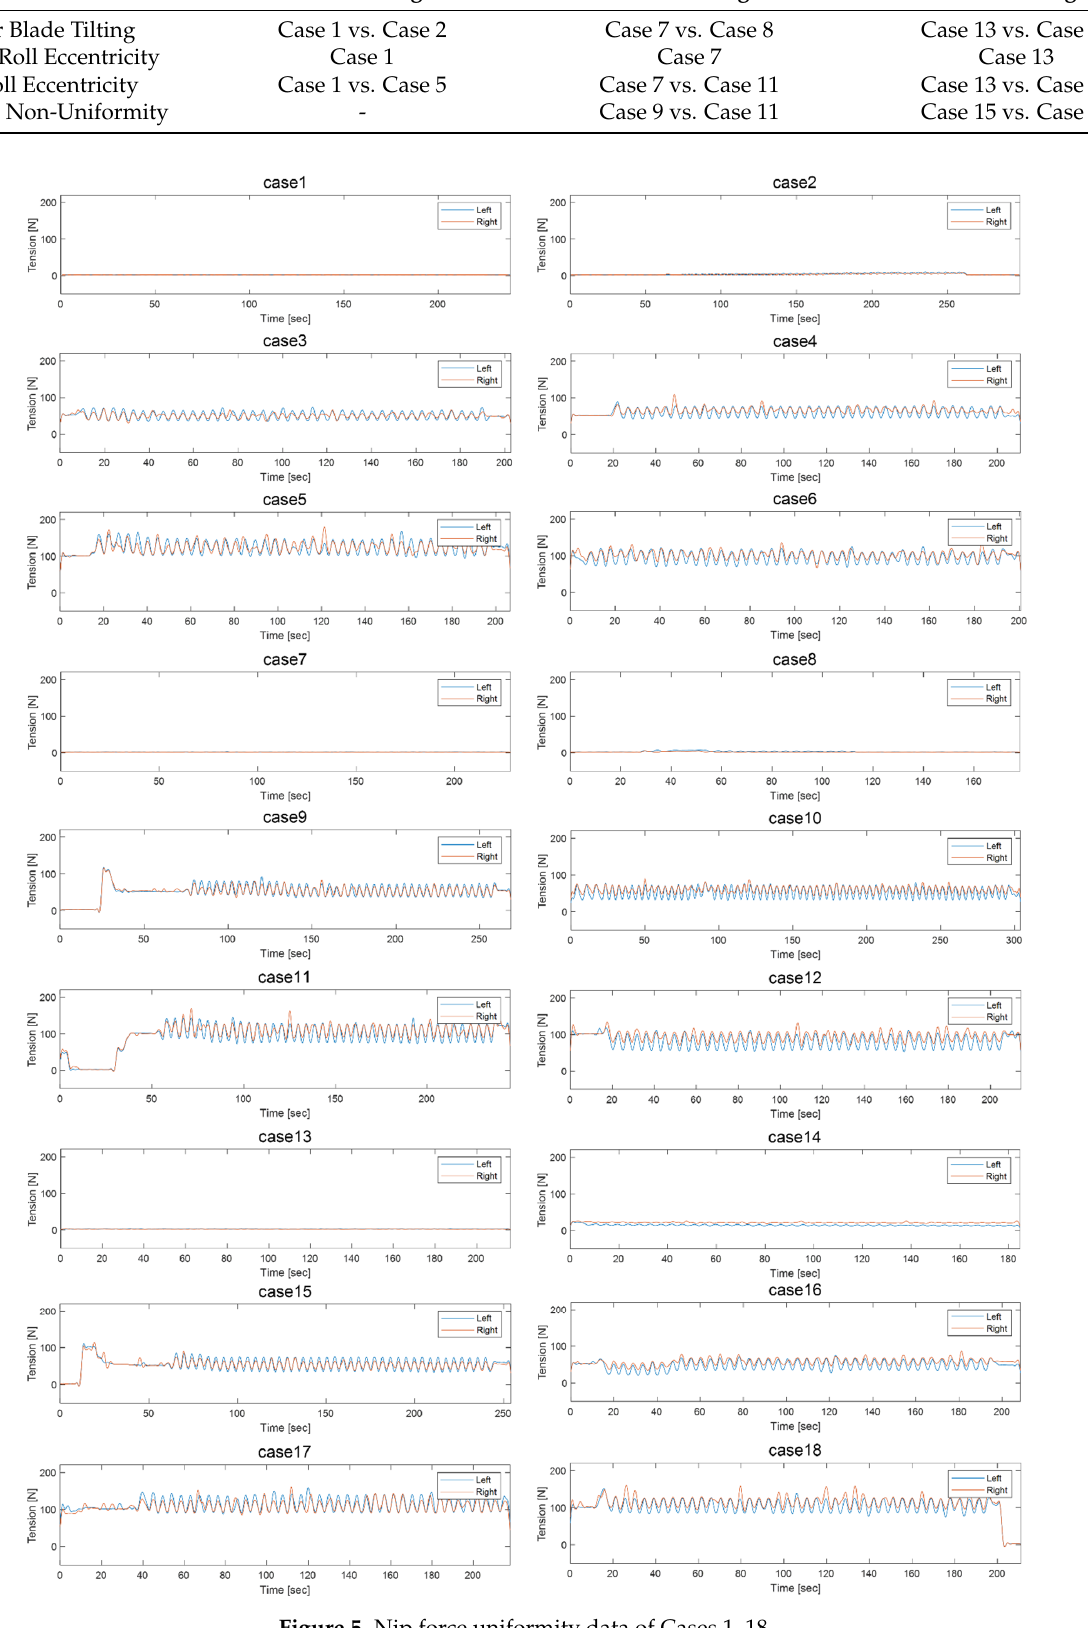
Table 3. Case comparison for fault diagnosis of possible main faults during printing process of gravure printing system. Case No.